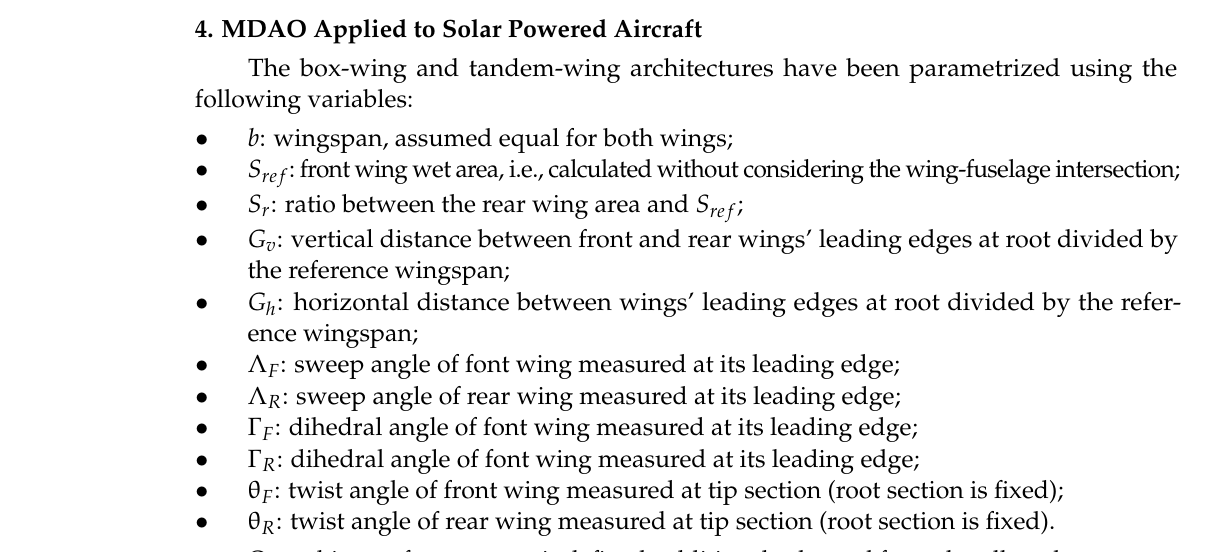
Figure 11. Percentage differences on centre of pressure ( X CP , left ) and neutral point ( X NP , right ) longitudinal positions predictions (SD2020 underestimates when values are positive).